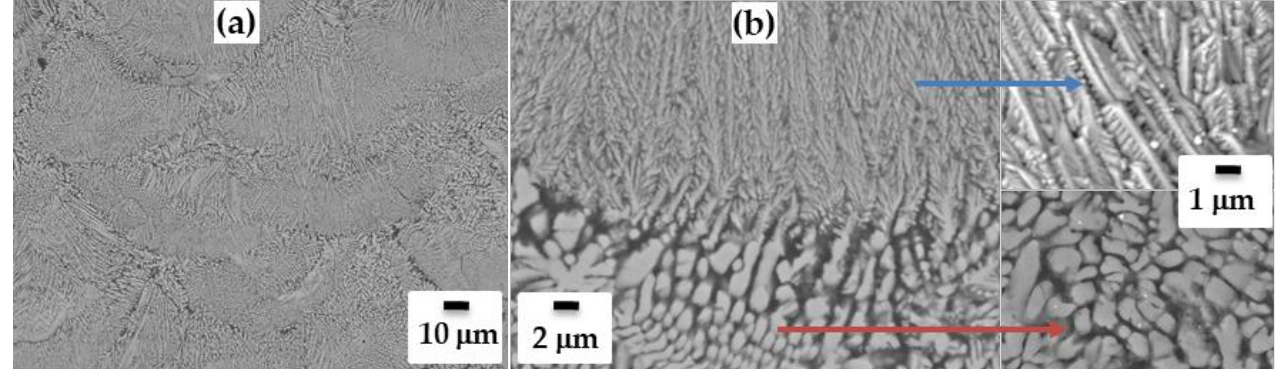
Figure 3. SEM images of fracture of SLM-ed compact from SHSed MoSi 2 -30 wt.%AlSi10Mg alloy mixture at different magnifications ( a , b ).